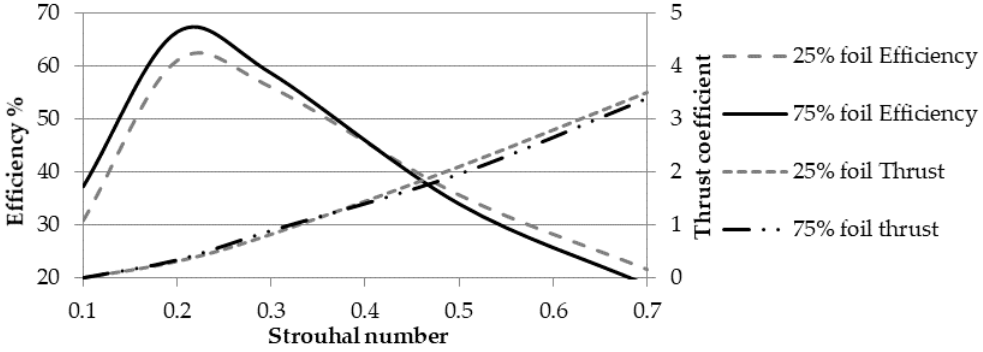
ffi ciency and average thrust coe ffi cient obtained by CFD Figure 13. Propulsive efficiency and average thrust coefficient obtained by CFD analysis. Figure 13. Propulsive e